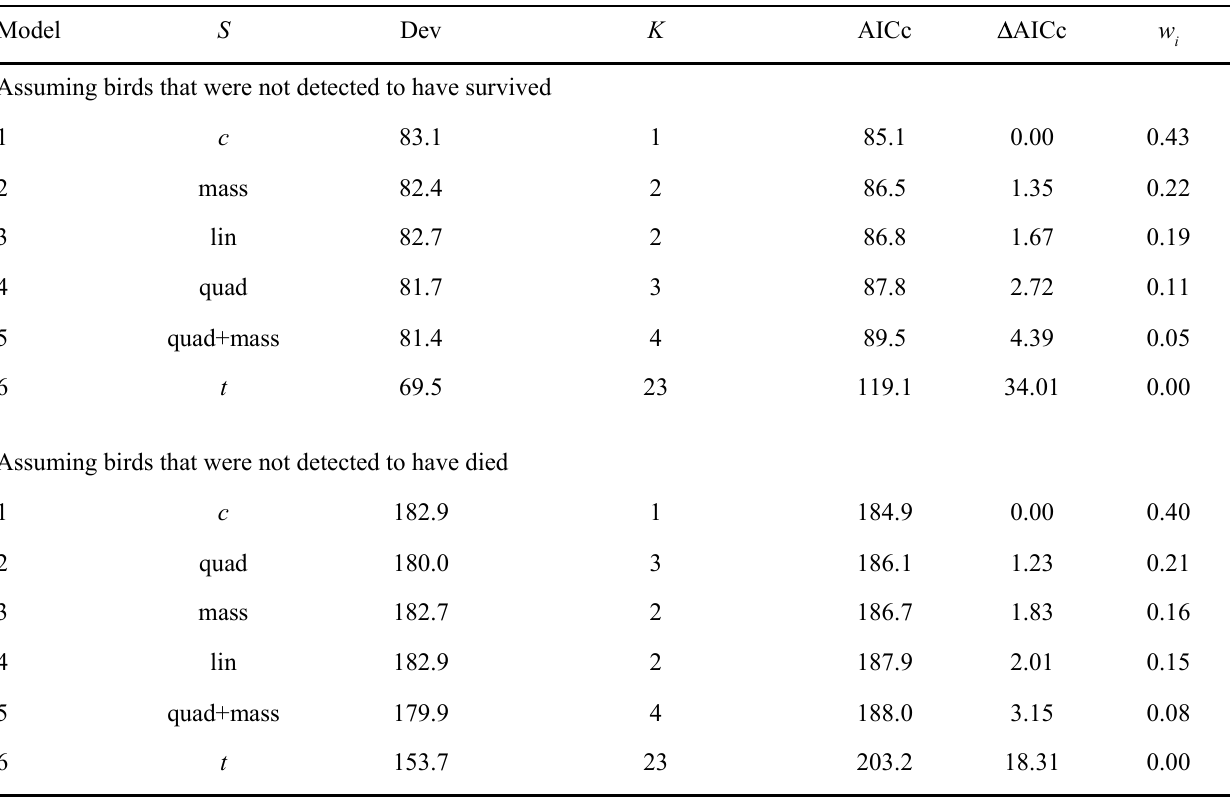
Table 2. Comparison of nest survival models examining the survival of radio-marked females during the breeding season ( n = 40 females). Females included in the analysis were marked at three Greater Prairie- Chicken ( Tympanuchus cupido ) leks between 2003 to 2005 in northeast Kansas and were detected two weeks after banding. Seventeen birds were not detected during the period two weeks after banding and the end of the breeding season (1 September). Two data sets were analyzed: one assuming these missing birds were alive at the end of the study and the other assuming these birds were dead. Table abbreviations are as follows: S = parameters included in the survival model; Dev = deviance; K = number of parameters; AICc = Akaike’s Information Criterion corrected for small sample sizes; AICc = difference of the AICc value in the given model compared to the minimum AICc model; and w = Akaike weights. Model factors i are as follows: t = time; mass = mass at initial capture; lin = linear seasonal trend; quad = quadratic seasonal trend; c = constant; and + = additive